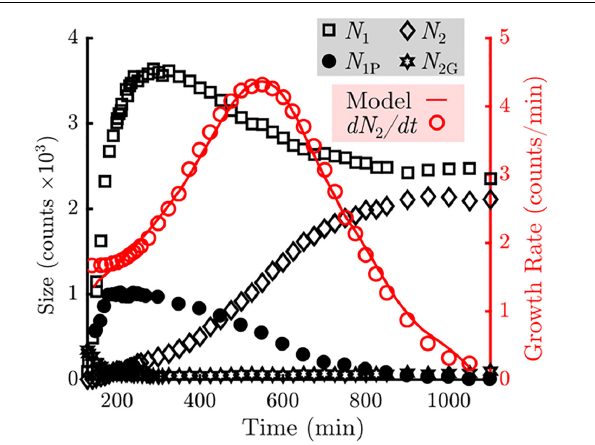
FIGURE 4 | Measurement of the counts of particles in various states in the sample (Left axis, black). The number of particles in the bottom ( N 1 ) layers are indicated by the squares. The number of particles in the top ( N 2 ) layers are indicated by the diamonds. The number of unblocked perimeter particles ( N 1 P ) are indicated by the closed circles. The number of gaseous particles promoted off of the sample floor ( N 2 G ) are indicated by the stars. Measurement of the growth rate of the top layer as a function of time is indicated by the open circles (Right axis, red). A fit using the model described in Eq. 1 is overlaid as a solid red